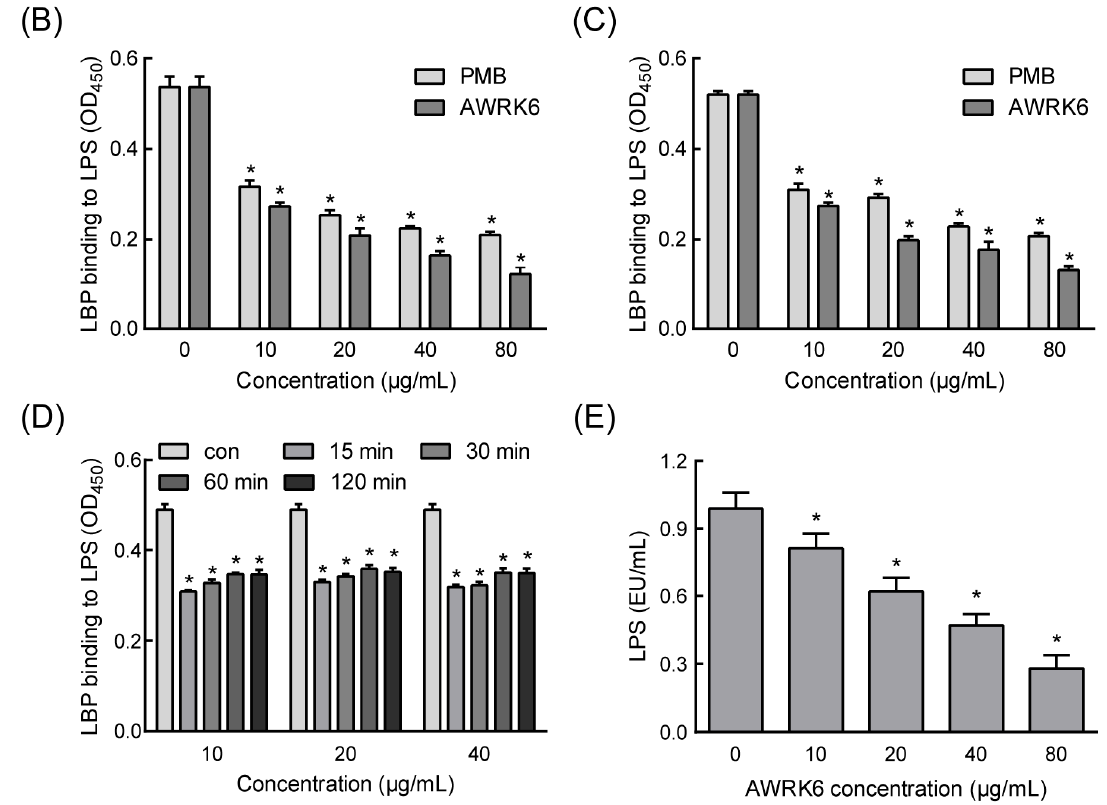
Figure 1. AWRK6 inhibited the binding of lipopolysaccharides (LPS) with LPS binding protein (LBP) in vitro. ( A ) The helical wheel projection of AWRK6. ( B ) The inhibition effects of AWRK6 on the binding of LBP with LPS when AWRK6 was added 1 h before LBP. ( C ) The inhibition effects of AWRK6 on the binding of LBP with LPS when AWRK6 and LBP were added at the same time. ( D ) The inhibition effects of AWRK6 on the binding of LBP with LPS when AWRK6 was added after incubation with LBP for 15, 30, 60, and 120 min. ( E ) The neutralization effects of AWRK6 on LPS, detected by LAL assay. * p < 0.05 compared with the 0 ( B , C , and E ) or con ( D ) groups.